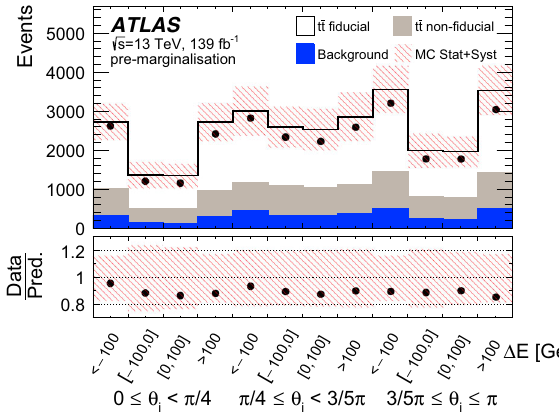
Fig. 5 Comparisonofdatatotheprior(pre-marginalisation)prediction for the (cid:5) E vs. θ j distribution used in the unfolding. The 3 differential bins in θ j and 4 (cid:5) E bins are concatenated to give 12 bins as shown in Fig. 3. The shaded red bands correspond to the total uncertainty of the